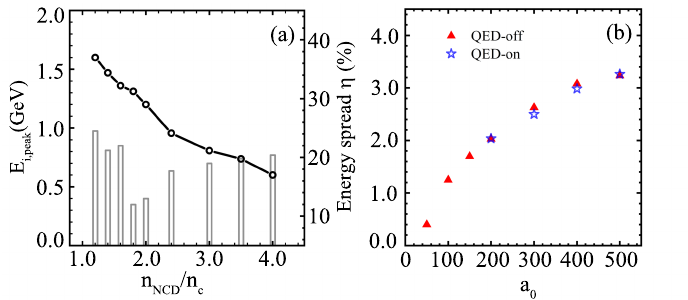
Figure 5. ( a ) The proton peak energy E i , peak (the line with circles) and the corresponding energy spread η (histograms) as a function of the initial density n NCD of the NCD plasma. ( b ) The proton peak energy E i , peak as a function of the laser amplitude a 0 , where the the red triangles and blue stars show the results with the QED effects switched off and switched on,